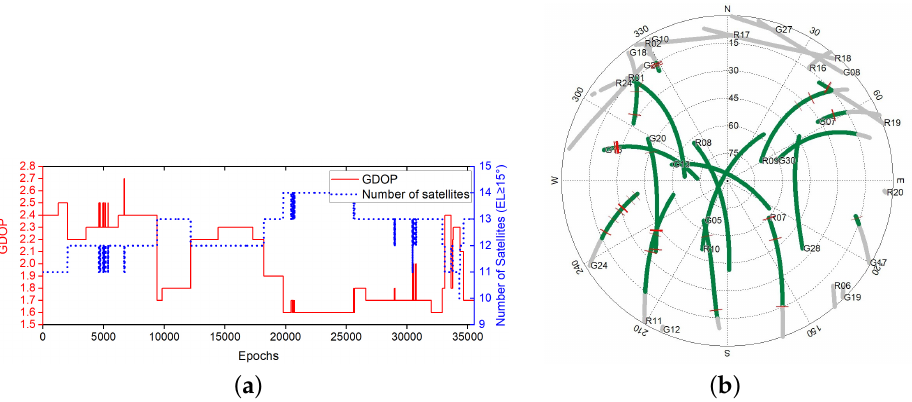
Figure 5. Geometric Dilution Precision (GDOP) and Sky Map during data sampling of experiment Section 3.2.1 ( a ) GDOP values and number of satellites. ( b ) Sky map of visible satellites, with a gray track indicating that the satellite’s altitude is less than 15 ◦ , and the red line indicating cycle slips. Table 1. The validation status of the relative motion vector solutions: kinematic experiment Section 3.2.1.